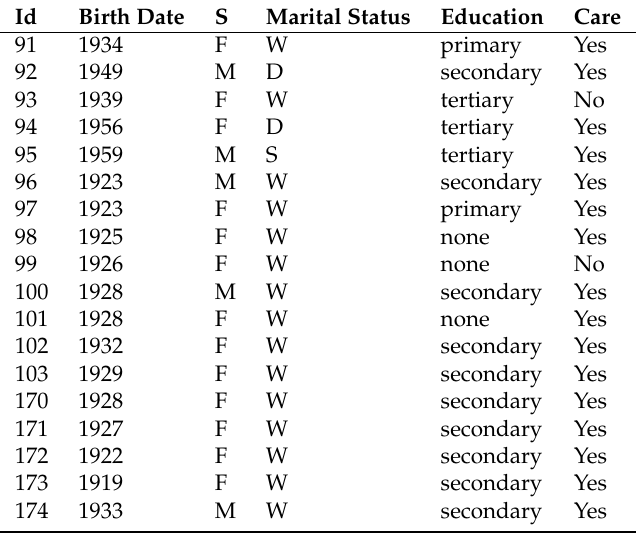
Table 1. Montpellier pilot site participants’ social